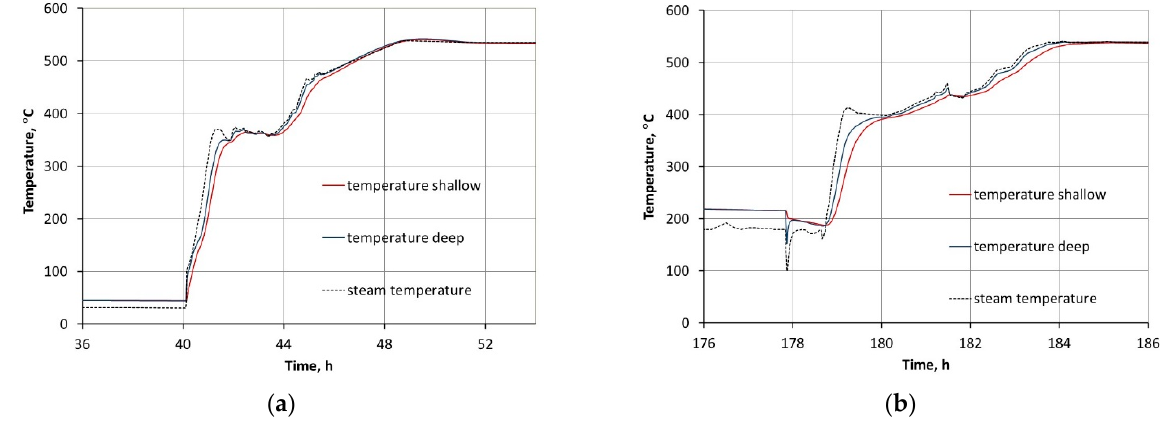
Figure 4. Graphs of steam and metal temperature changes at selected points on the Y-shaped junction as a function of time for ( a ) the cold and ( b ) the hot startup periods.